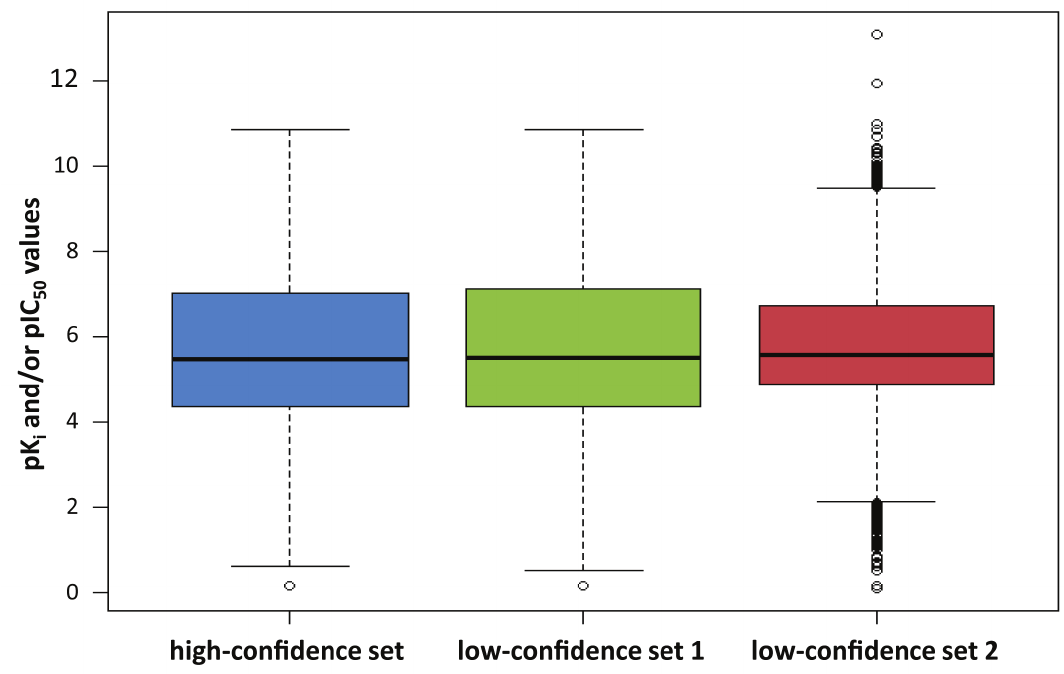
Figure 10. Potency distribution. The distribution of pK and/or pIC values in three data sets with varying confidence levels is reported in box i 50 plots. Each box plot provides the lowest potency value within the 1.5 interquartile range of the lower quartile (bottom line), lower quartile (lower boundary of the box), median value (thick line), upper quartile (upper boundary of the box), and the highest value within the 1.5 interquartile range of the upper quartile (top line). Potency values falling outside these ranges are indicated by empty